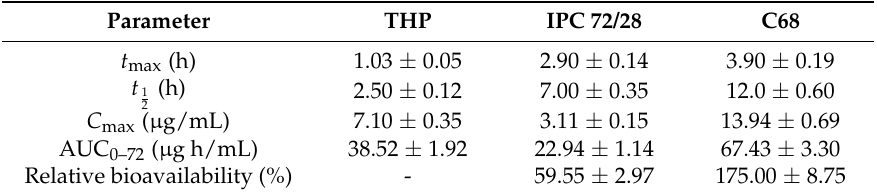
Table 6. Pharmacokinetic parameters obtained for raw theophylline and theophylline-loaded matrices.